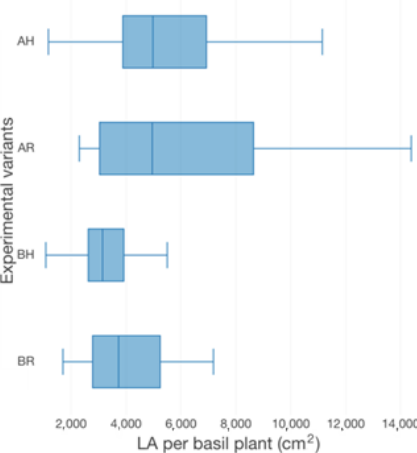
Figure 4. Boxplot for fresh weight per basil plant for each experimental variant, at the end of the trial.